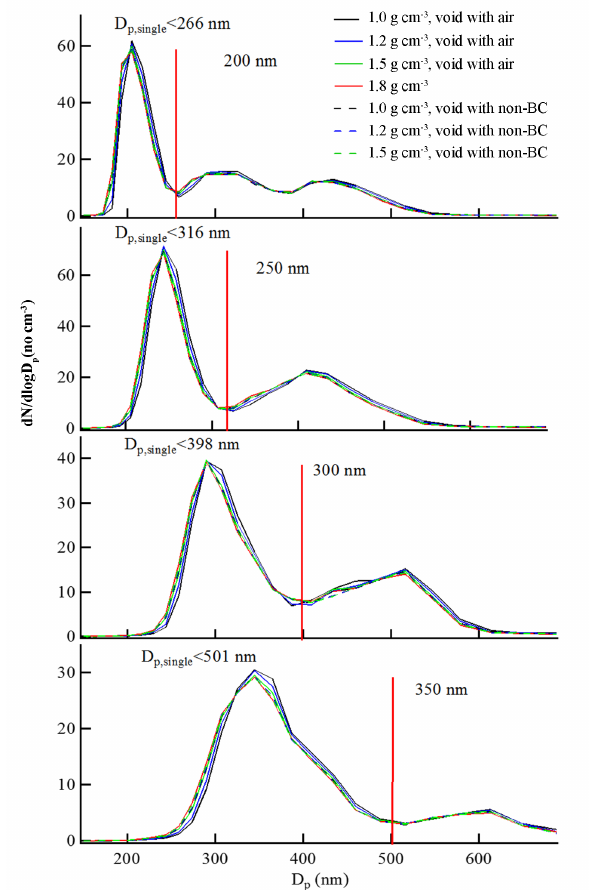
Figure 4. The number size distributions of size-resolved ambient In-BC particles with different core densities and void types.